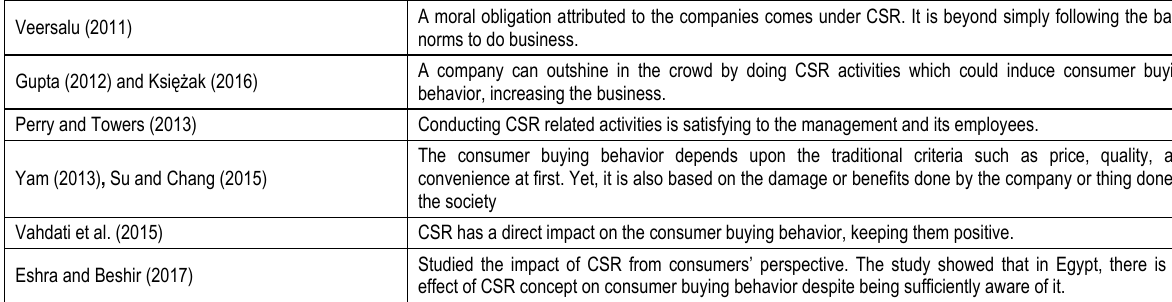
Table 1 (cont). Literature review